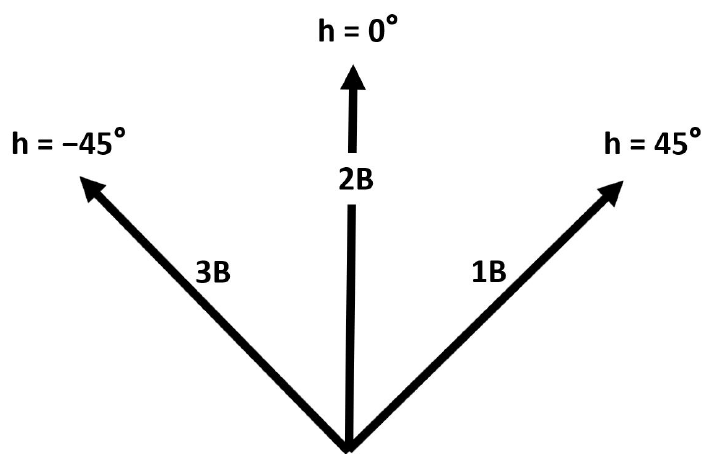
Figure 2. Horizontal angle h in the plane of the playing field where h = − 45 ◦ is in the direction of third base (3B), h = 0 ◦ is in the direction of second base (2B), h = 45 ◦ is in the direction of first base (1B); the three rays intersect at home